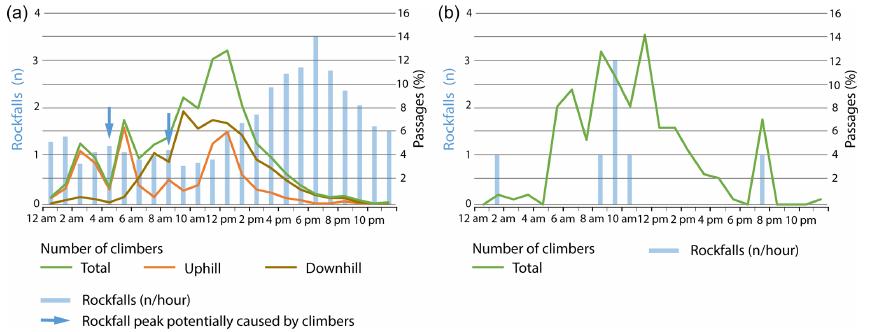
Figure 8. Hourly distributions of climber traffic and number of rockfalls per hour: (a) average over the whole period of measurement and (b) average specifically for 31